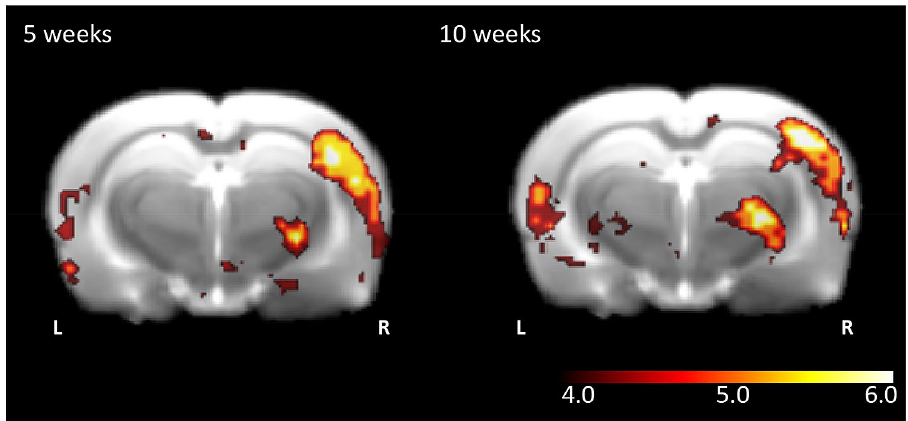
Figure 2. The effect of whisker stimulation block > control block over all subject groups. In both the perinatally SSRI exposed and control groups whisker stimulation to the left side is associated with increased activation of the barrel cortex at the contralateral side (5 weeks: z-max = 6.43, p < 0.001; 10 weeks: z-max is 6.25; p < 0.001). Additionally, there is strong activation in thalamic projection sides and sensory relay regions like the ventral posteromedial nucleus and posteromedial complex region. Cluster activation is shown on an in-house rat template and z-scores are depicted on the scale